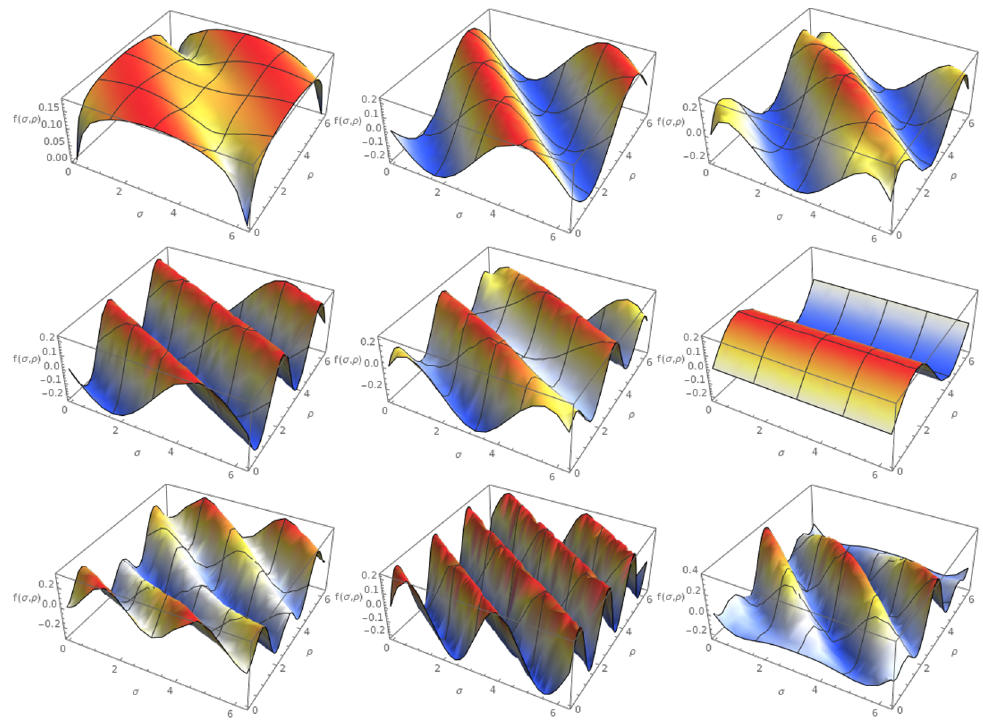
Figure 3 . First nine eigenfunctions of the differential operator for periodic boundary conditions with